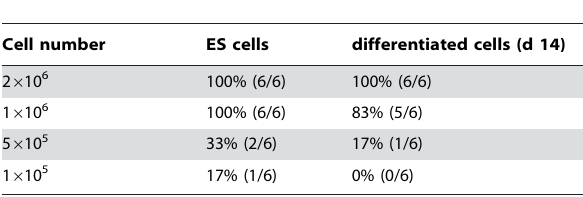
Table 1. Tumor formation after subcutaneous inoculation of various numbers of ES cells or in vitro differentiated cells in 129Sv mice.